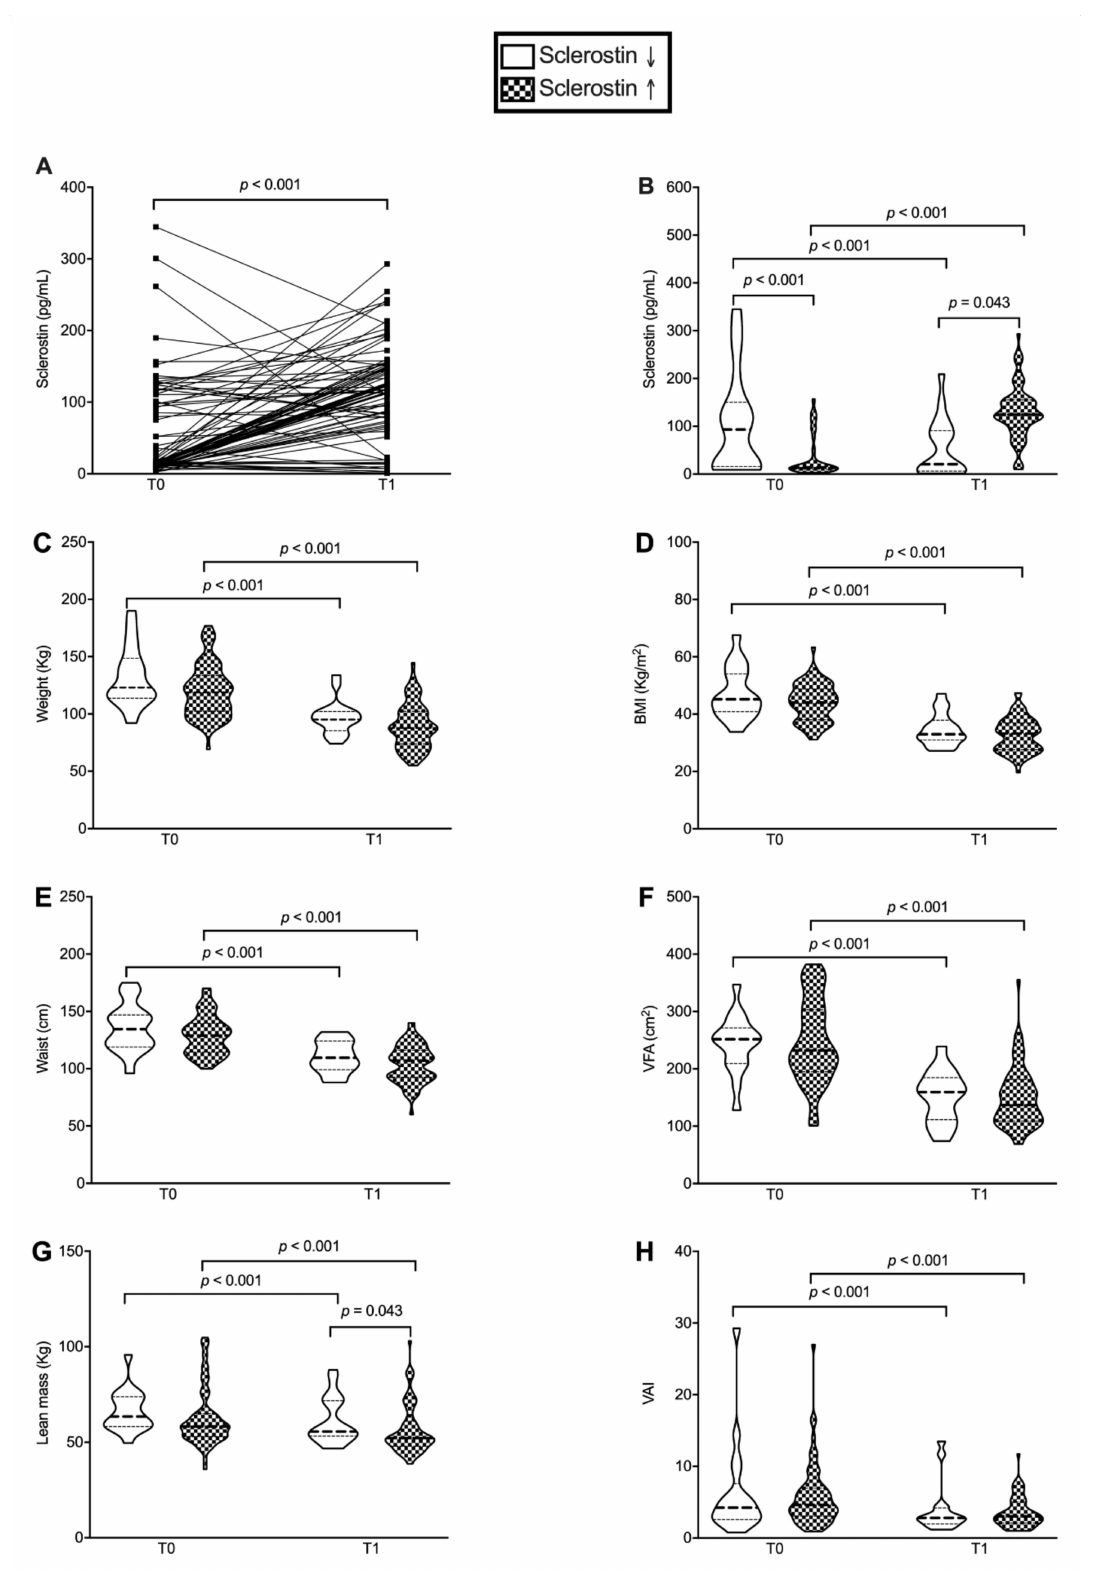
Figure 2. Different clinical response according to post-surgical change in serum sclerostin. These subgroups ( A , B ) did not show significant differences in anthropometric parameters (weight, body mass index (BMI), waist circumference, visceral fat area (VFA) and visceral adiposity index (VAI)), except for lean mass ( C – H